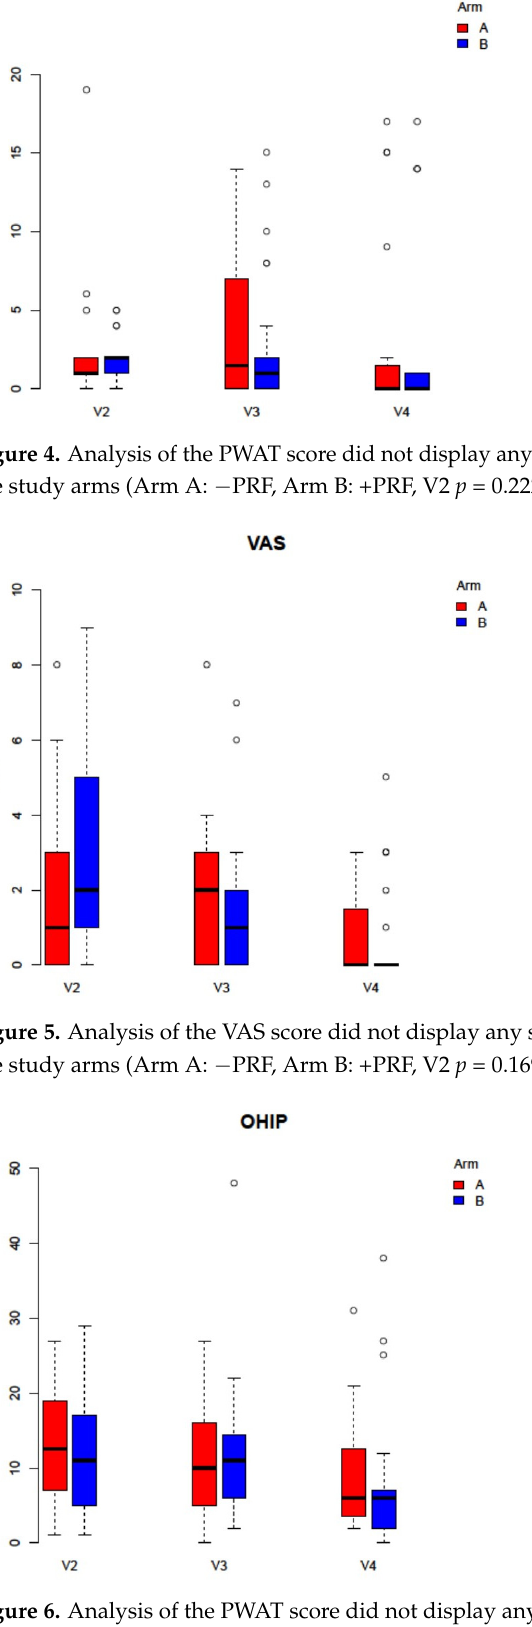
Figure 6. Analysis of the PWAT score did not display any statistical significances between the study arms (Arm A: − PRF, Arm B: +PRF, V2 p = 0.222, V3 p = 0.504, V4 p =